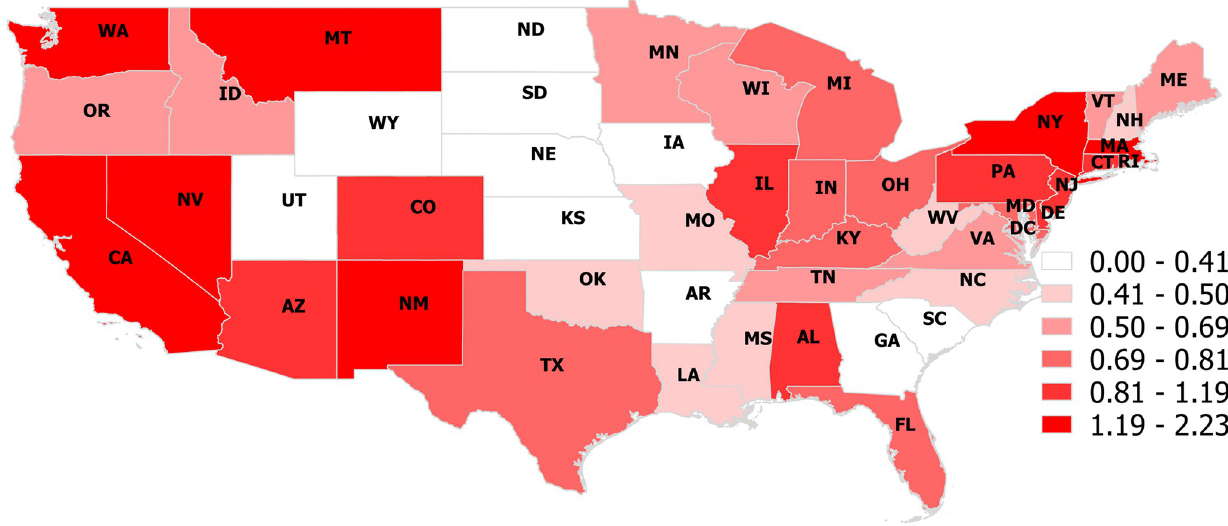
Fig 2. Choropleth map illustrating the proportion of dog-associated poisoning calls to the Animal Poison Control Center that were related to a cannabinoid poisoning in each continental US state (2005–2014).